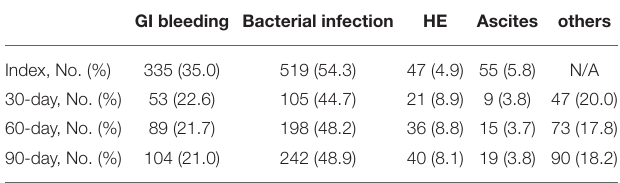
TABLE 1 | Cirrhosis-related index hospitalizations and readmissions. TABLE 2 | The HR values of the independent risk factors for prediction of 90-day readmission in patients with acute decompensated